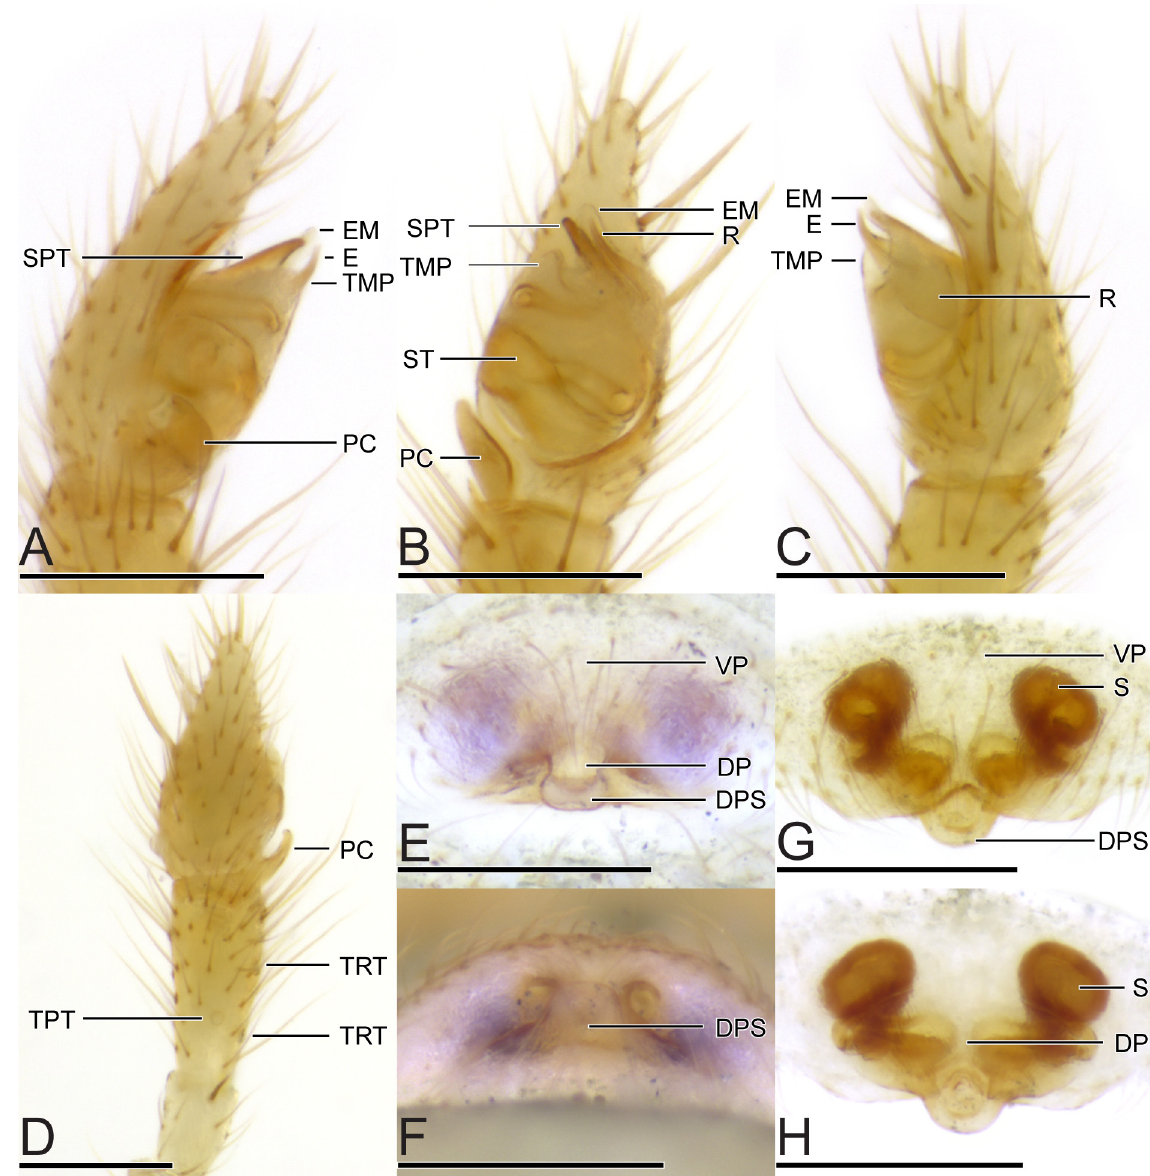
Fig. 5. Afroneta flavescens sp. nov. A–D . Holotype, ♂ (UPSZMC 67563). A . Palp, retrolateral. B . Ventral. C . Prolateral. D . Dorsal. E–H . Allotype, ♀ (UPSZMC 67564). E . Epigyne, ventral. F . Aboral. G . Cleared vulva, ventral. H . Cleared vulva, dorsal. Scale bars: